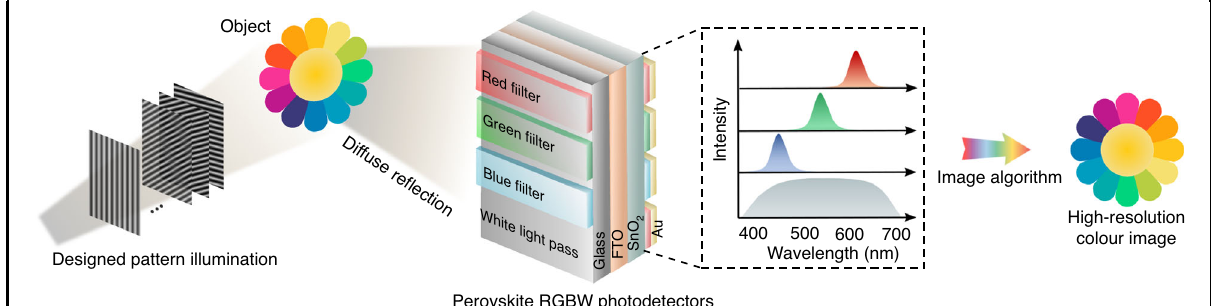
Fig. 1 A human vision inspired perovskite-based color imaging system. Schematic of the human vision inspired perovskite-based color imaging system consisting of predesigned pattern illumination, RGBW perovskite PDs, and Fourier imaging